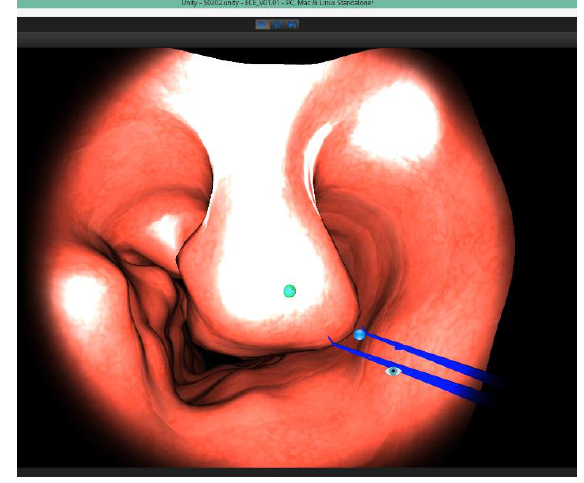
Figure 6. ‘Simulated’ Performance of a Participant (Scenario-2)